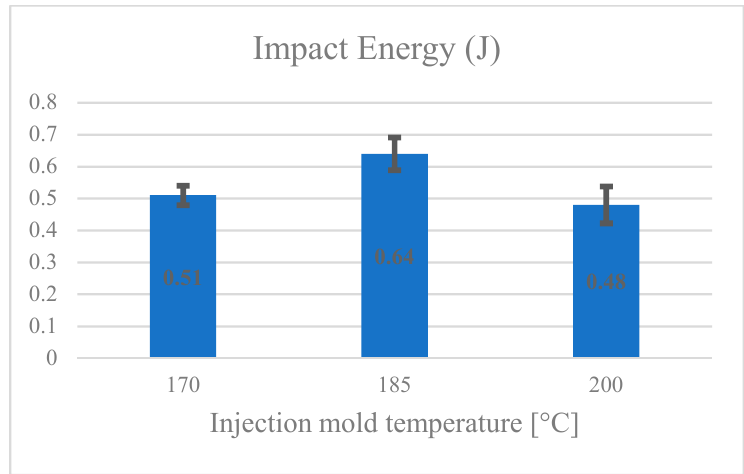
Figure 8. Effect of injection mold temperature on impact energy.